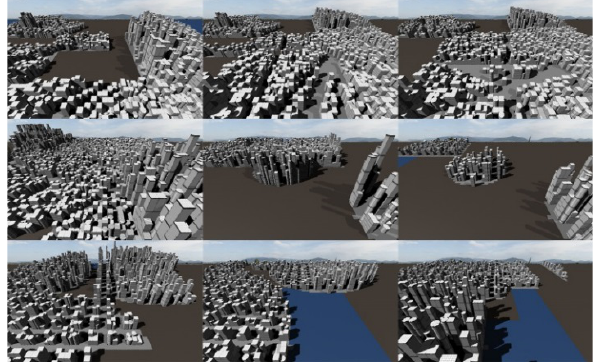
Figure 12. Generation 14 of the same HBGA run as above, showing mostly land-based candidates